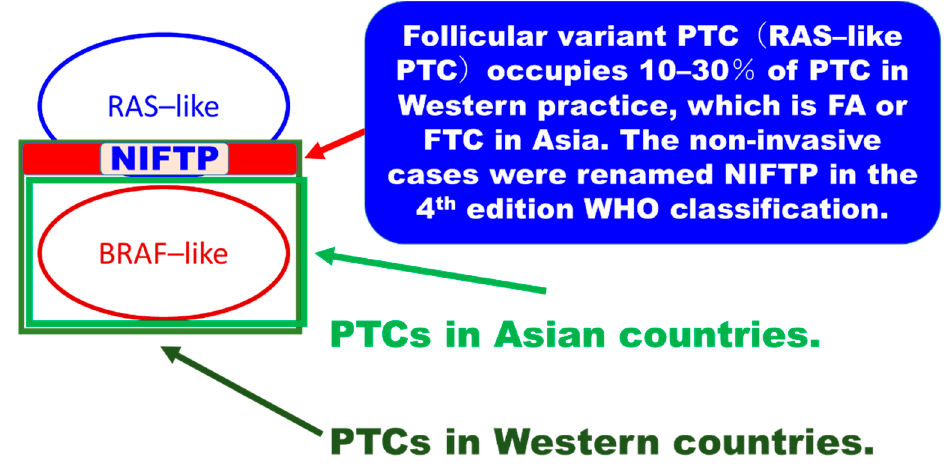
Figure 3. Difference between the Asian and Western definitions of papillary thyroid carcinoma. There was a non-overlapping part (red highlighted) between the Western and Asian definitions of papillary thyroid carcinoma (PTC). When superimposing Western PTCs on Asian PTCs, the non-overlapping part (red part) is the RAS -like tumor, which is morphologically a follicular variant PTC that accounts for 10–30% of the US PTC cohort. It was renamed NIFTP when noninvasive and downgraded to the borderline (not malignant) tumor category in the 4th edition WHO classification of thyroid tumors in 2017 [22,31]. NIFTP: noninvasive follicular thyroid neoplasm with papillary-like nuclear features.